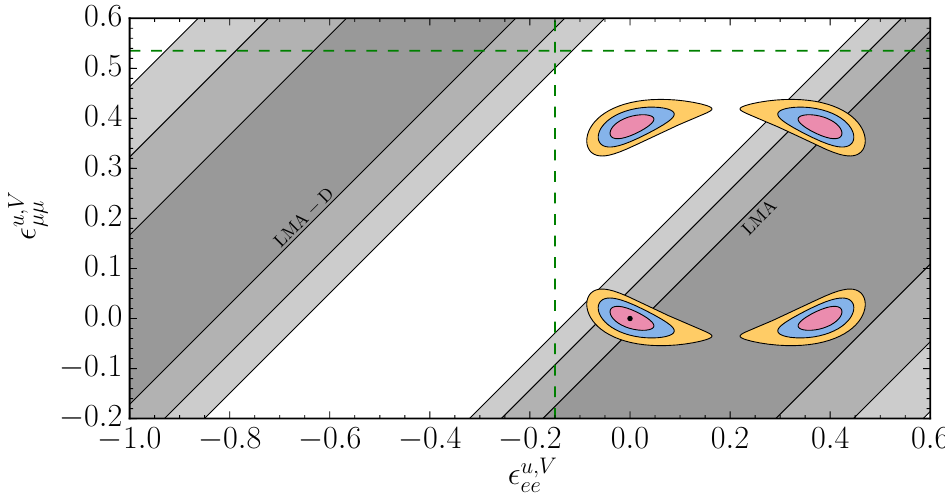
Figure 7 . Allowed regions in the plane of (cid:15) u;V and (cid:15) u;V from the COHERENT experiment ee (cid:22)(cid:22) (under the assumption of no NSI in the data | same as in (cid:12)gure 5) overlayed with the presently allowed regions from the global oscillation analysis. The two diagonal shaded bands correspond to the LMA and LMA-D regions as indicated, at 1, 2, 3 (cid:27) . The dashed lines indicate the values of NSI parameters for which COHERENT would not be able to resolve the LMA-D degeneracy, see appendix A for